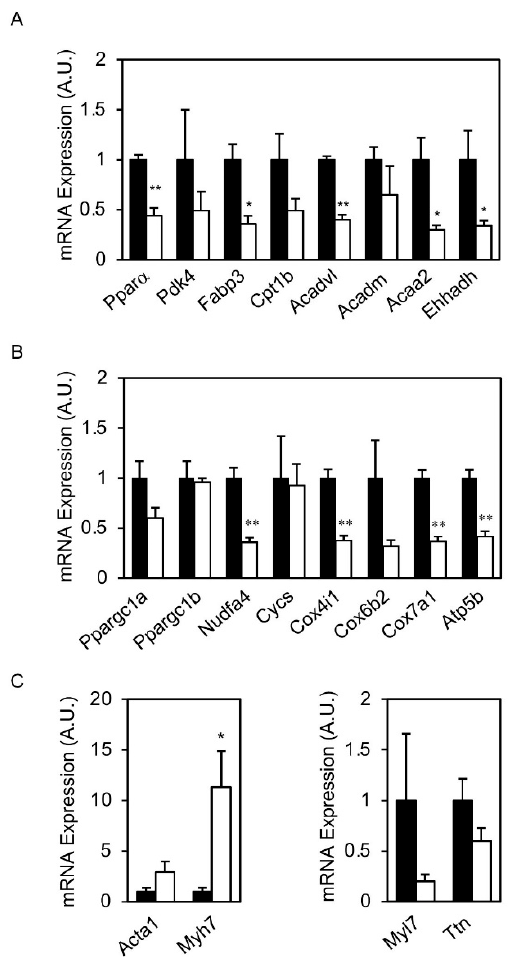
Figure 6. Expression of ERR γ target genes in adult L6 hERR γ -Tg mice. mRNA expression of genes related to lipid metabolism ( A ), OxPhos system ( B ), and sarcomeric proteins ( C ) was determined by real-time quantitative PCR. Data are mean ± SEM of 3–4 animals/group; * p = 0.05; ** p = 0.01.